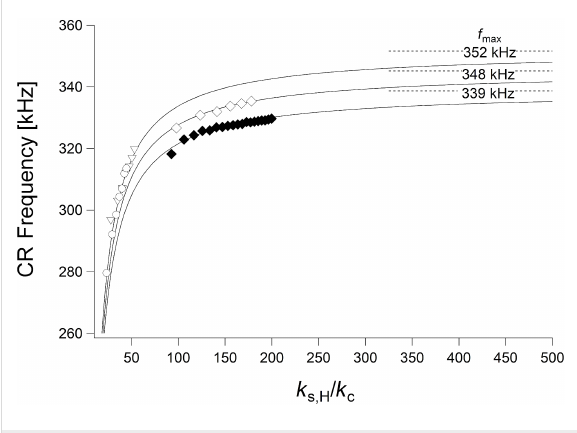
Figure 9: CR frequency as a function of the normalized contact stiff- ness α H = k s,H / k c on glass (open and full diamonds, two different mea- surements), bulk PMMA (triangles), and bulk PS (circles), fitted with Equation 16 (black curves). Dashed grey lines denote the maximun CR frequency attainable with the the respective values of f 1 0 and γ